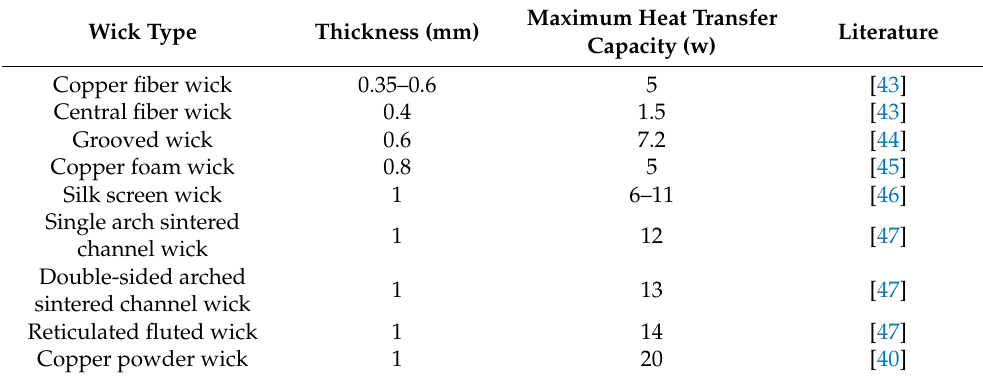
Table 4. Maximum heat transfer capacity of ultra-thin heat pipe with different wick structures and